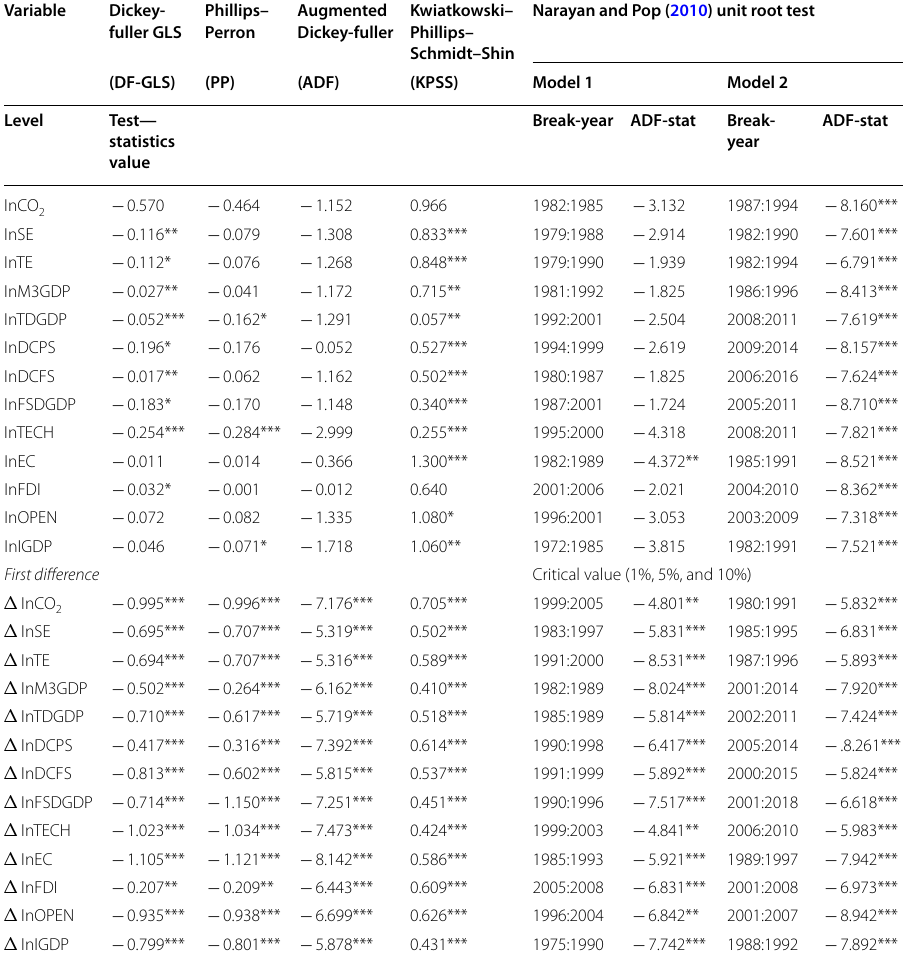
Table 4 Unit root